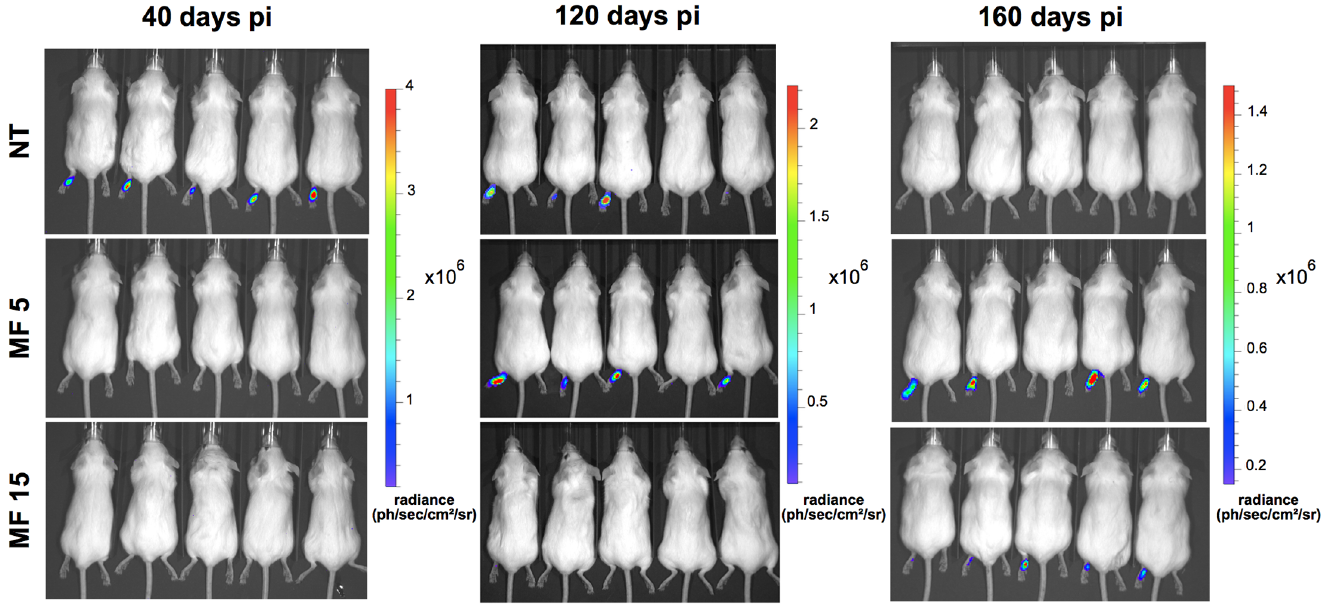
Fig 4. Parasite burden of left hind footpad of BALB/c mice treated with MF and evaluated by bioluminescence. Groups of 5 animals untreated (NT), or treated with 5 or 15 mg/kg/day MF (MF 5 and MF 15 respectively) were evaluated at 40, 120 and 160 days (6 th , 17 th and 23 th week respectively) post- inoculation (pi). The bars on the right show a pseudo-colour scale representing light intensities.